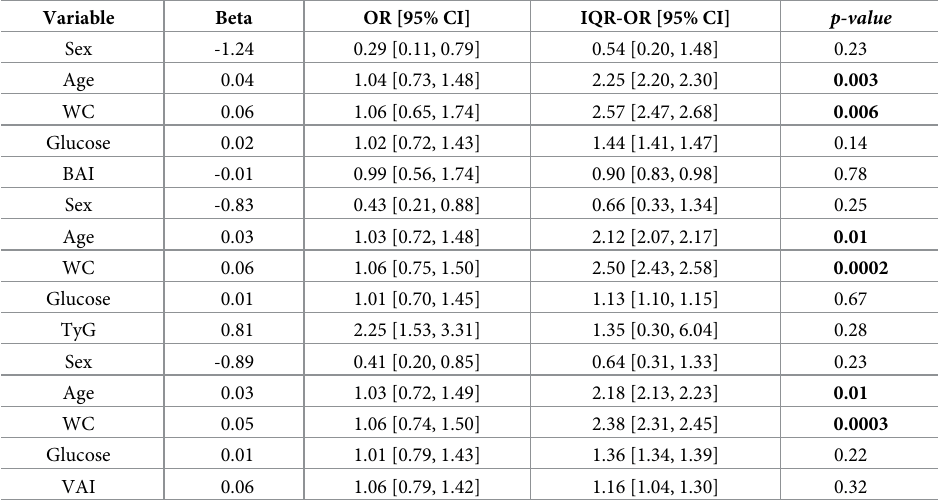
Table 4. Variables associated with diabetes mellitus in the Baependi Heart